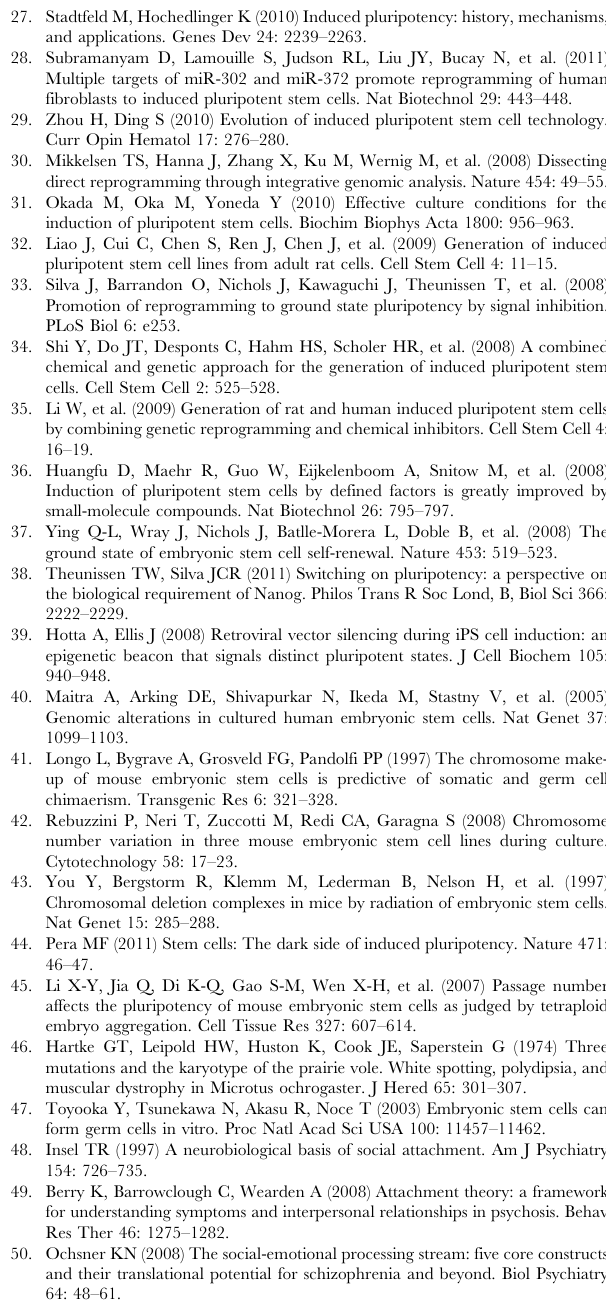
Table S2 Karyotype analysis of PVi lines. Metaphase chromosome spreads from each PVi line were enumerated to quantitate the degree of euploidy (1n= 27).